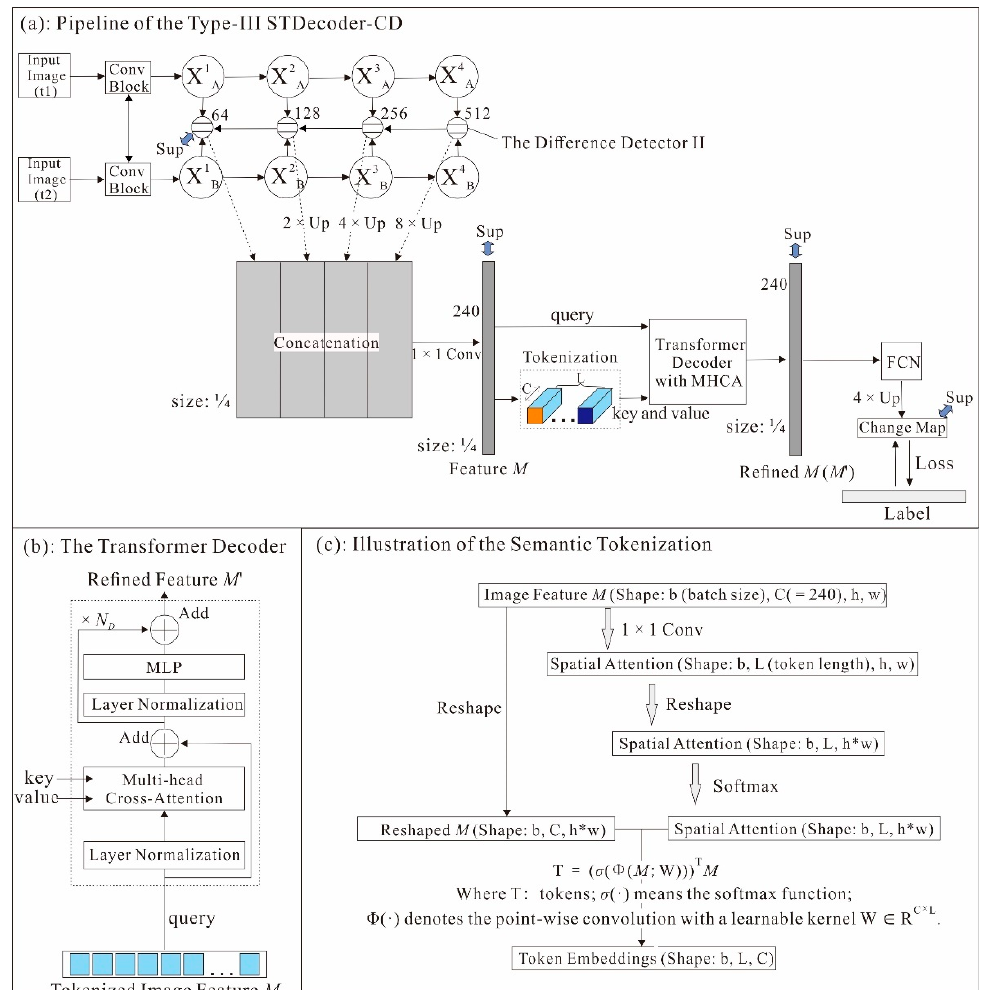
Figure 4. Flowchart of the Type III STDecoder-CD architecture. Note: ( b , c ) are modified after Ref. [19]. The legends in this figure are consistent with those in Figures 1–3 if not